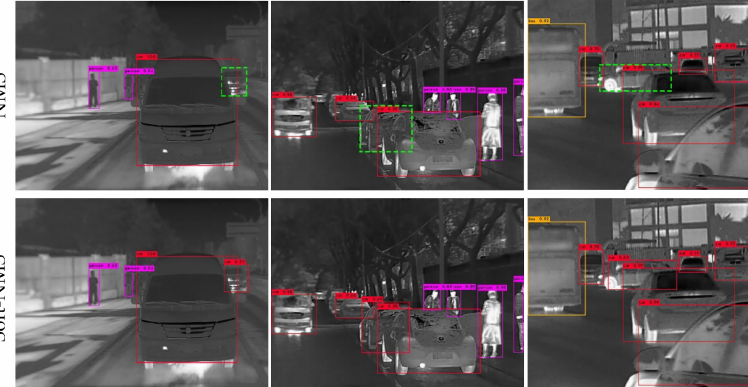
Figure 6. Comparison of the test results of the improved detector using non-maximum suppression (NMS) and the Soft-NMS algorithm, respectively. Both are using DarkNet-53 as the backbone.